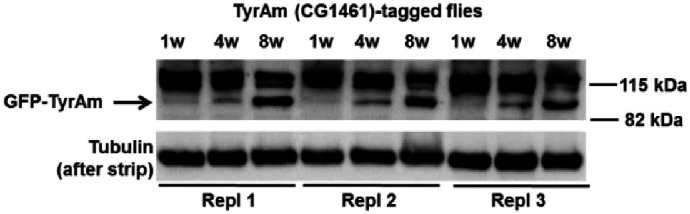
Age-dependent increase of GFP-tagged CG1461.Immunoblot analysis of GFP and tubulin in 1-week, 4-week, and 8-week CG1461(TyrAm)-GFP-tagged flies.